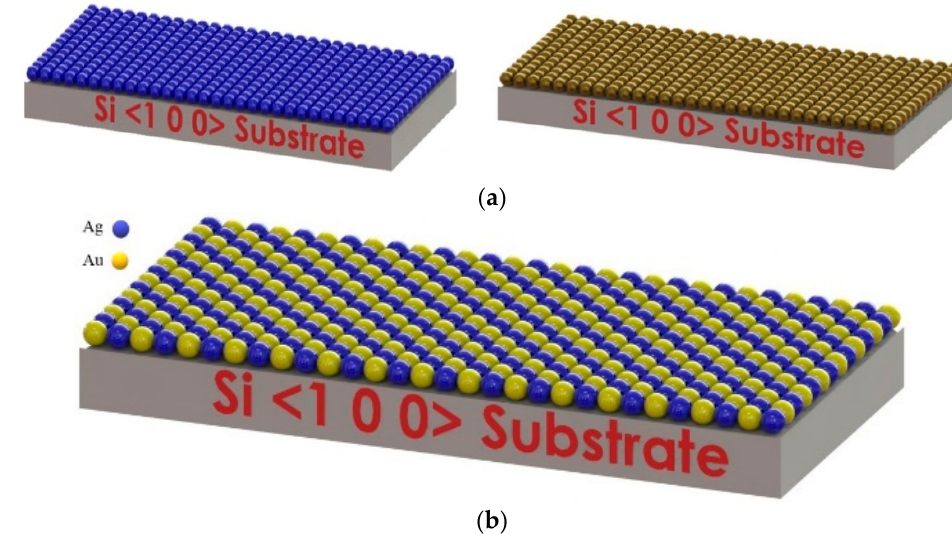
Figure 4. ( a ) Silicon substrate with Ag and Au single layers, ( b ) Silicon substrate with Ag–Au compound layer.